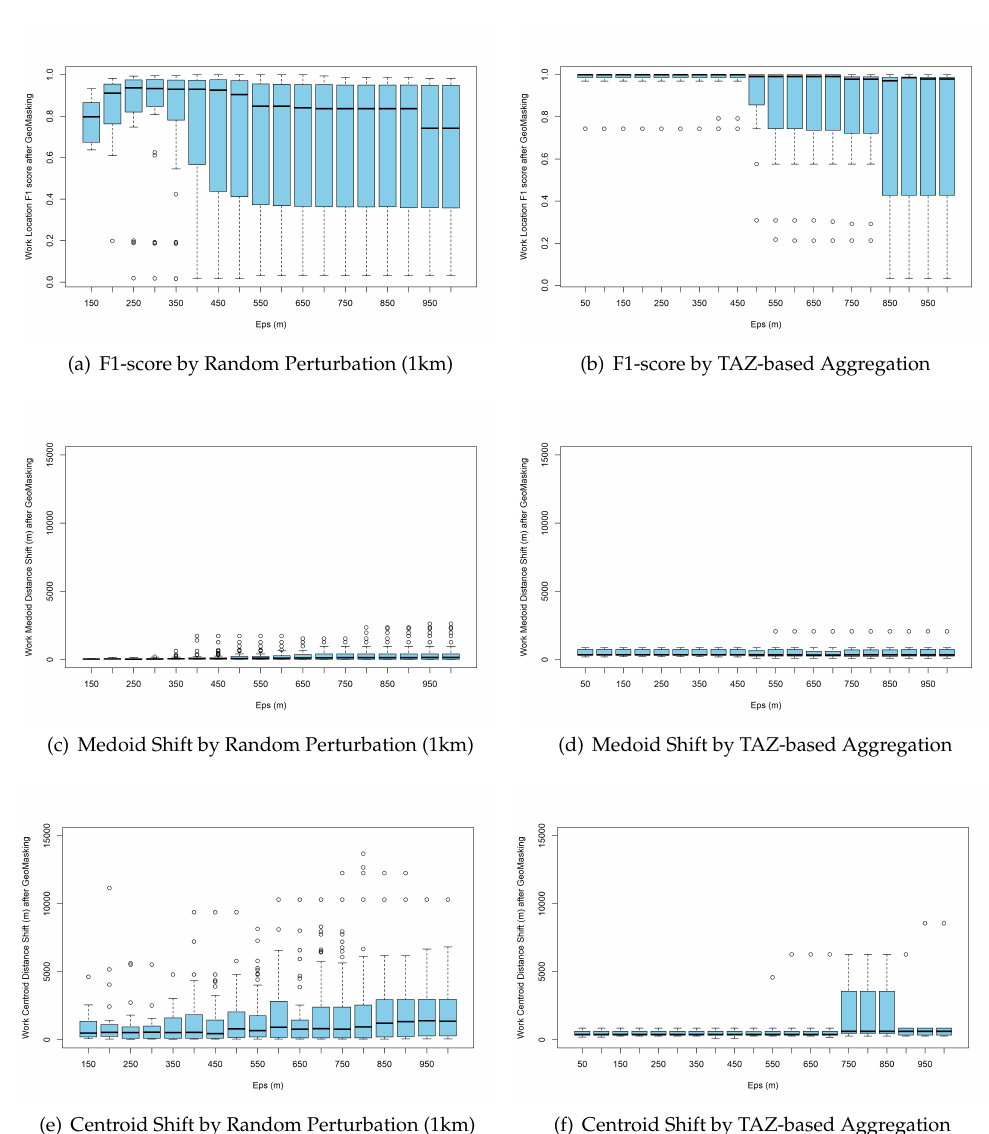
Figure 7: The boxplot of F1-score, medoid and centroid distance shift of work cluster de- tection with different DBSCAN parameters with random perturbation and the TAZ-based